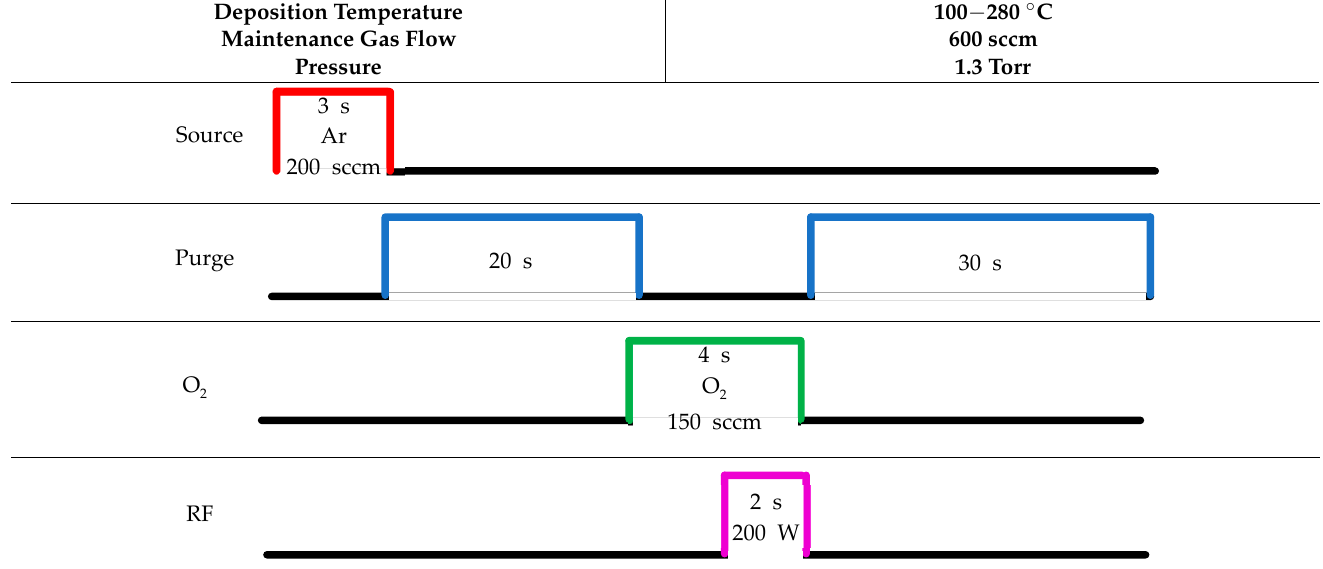
Table 2. Conditions for rapid thermal annealing of HZO thin films after TiN top electrode deposi- tion.